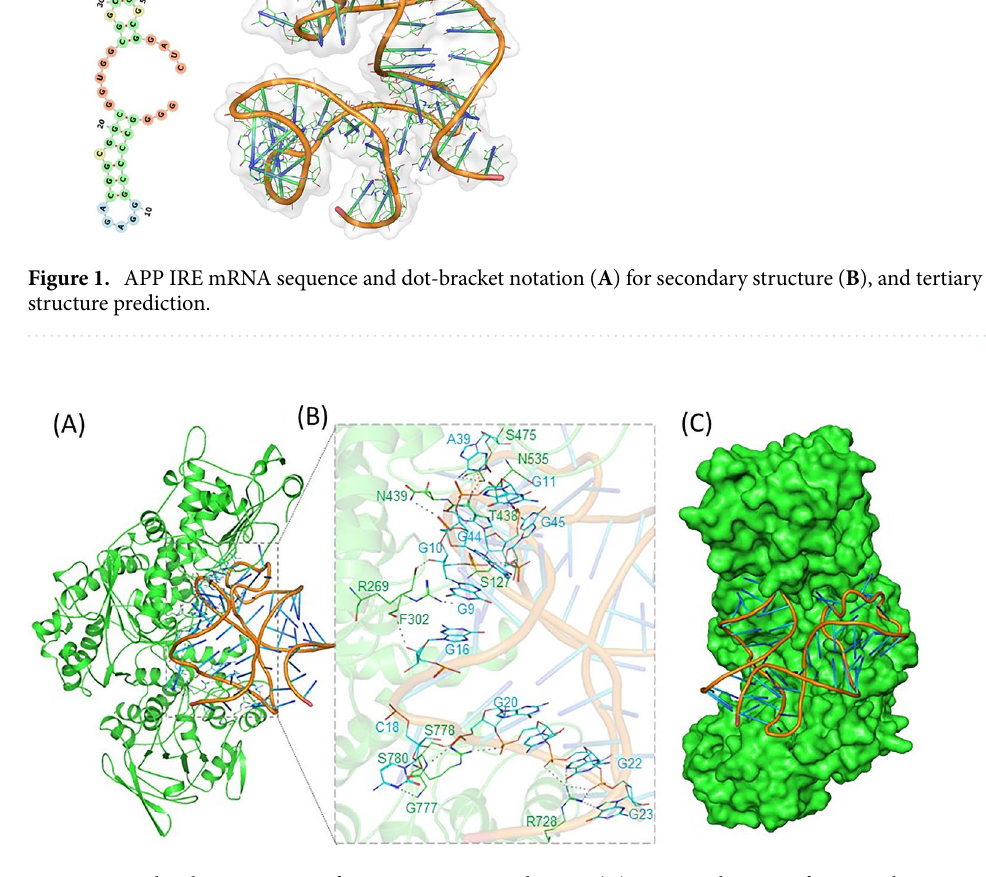
Figure 2. Molecular interaction of APP IRE mRNA with IRP1. ( A ) Cartoon diagram of IRP1 with APP IRE mRNA showing superimposition of docked IRE mRNA (light brown ribbon) with IRP1 (green ribbon) complex. ( B ) Zoomed cartoon diagram of IRP1 showing interactions between residues of IRP1 and IRE mRNA. ( C ) Binding cavity of IRP1 occupied by IRE